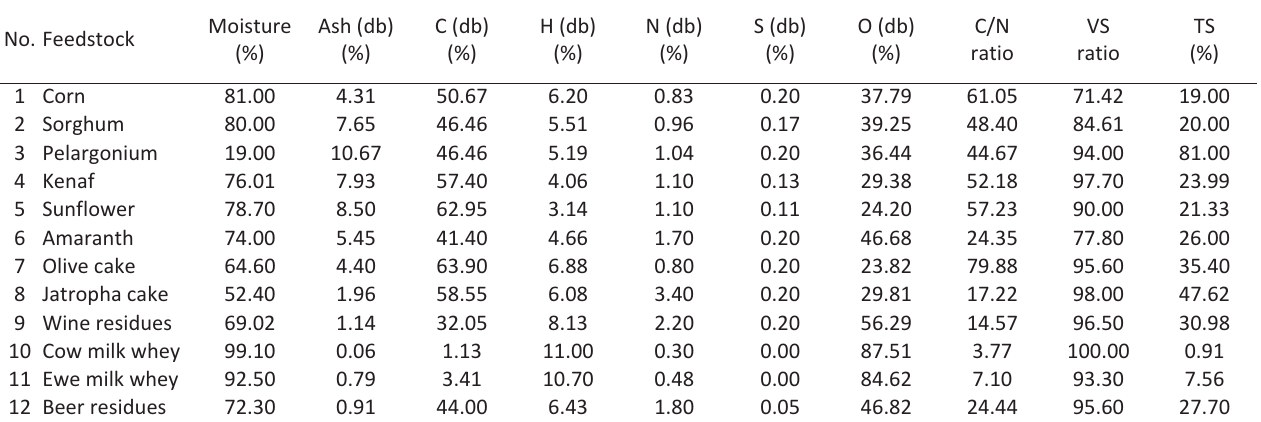
Table 3 - Feedstock elemental composition No. Feedstock